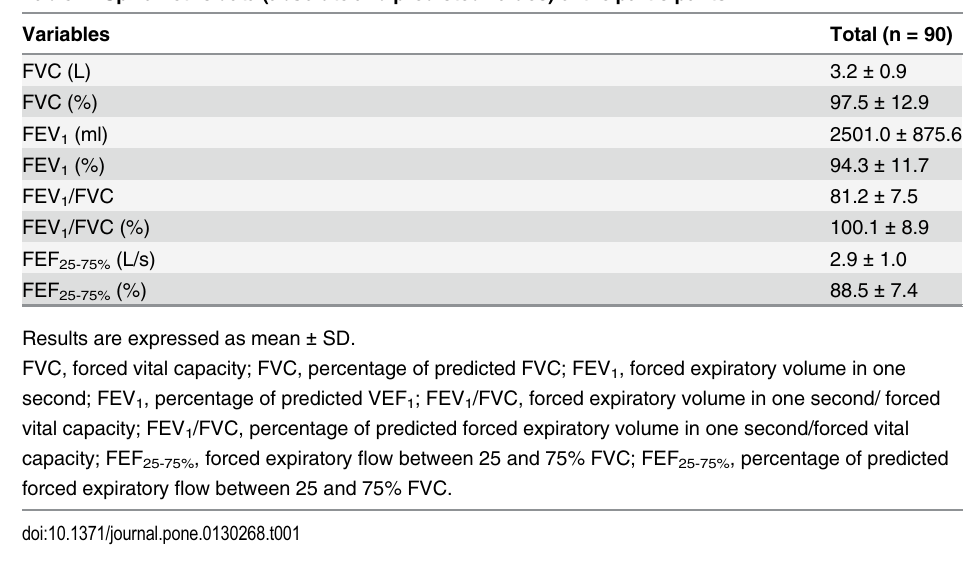
were obtained from all participants before and after the test. The test was interrupted only for the following reasons: diaphoresis, pale or ashen appearance, leg cramps, staggering, chest pain and intolerance dyspnea.